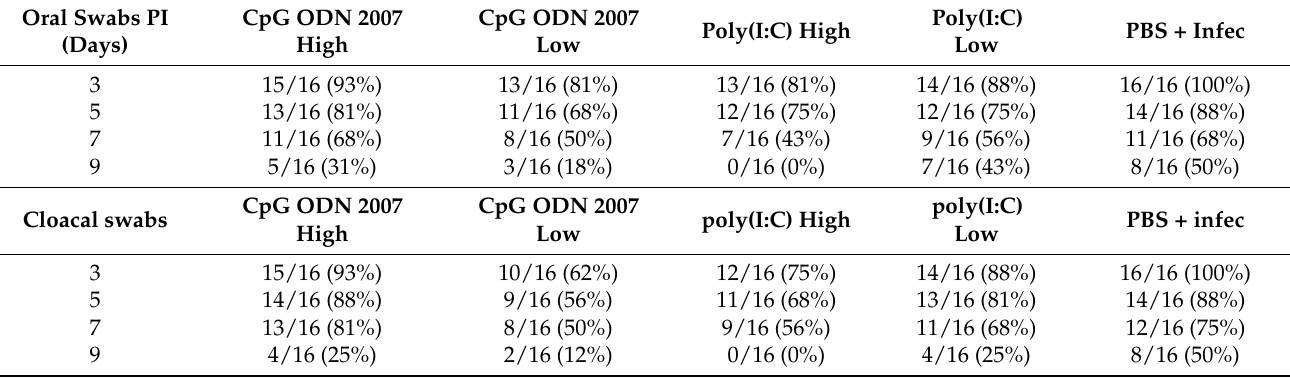
Table 2. Virus isolation from TLR-treated seeder chickens of different treatment groups ( n = 16).